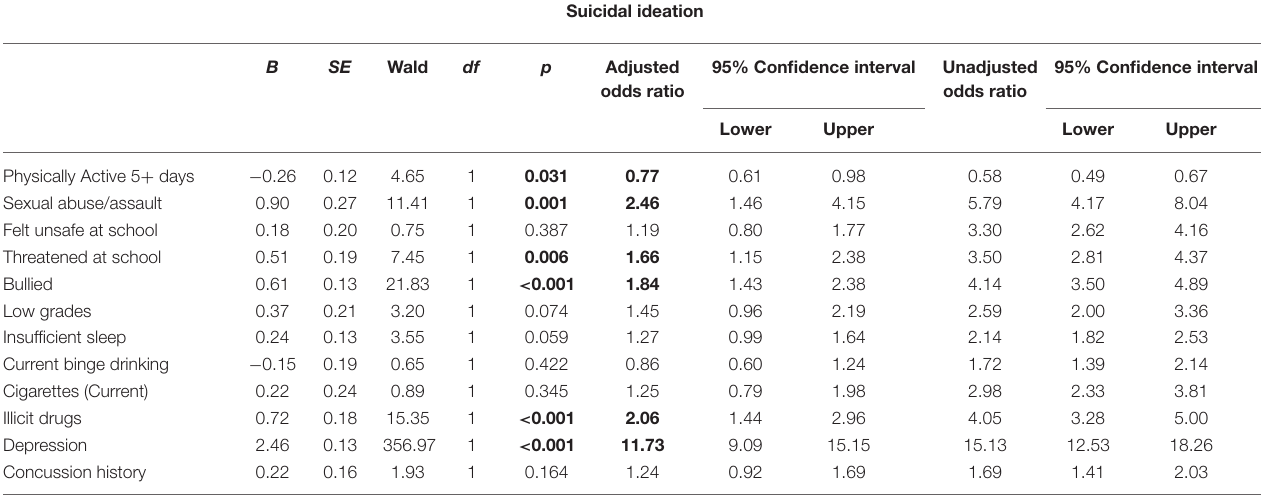
TABLE 4 | Logistic regressions predicting suicidality in